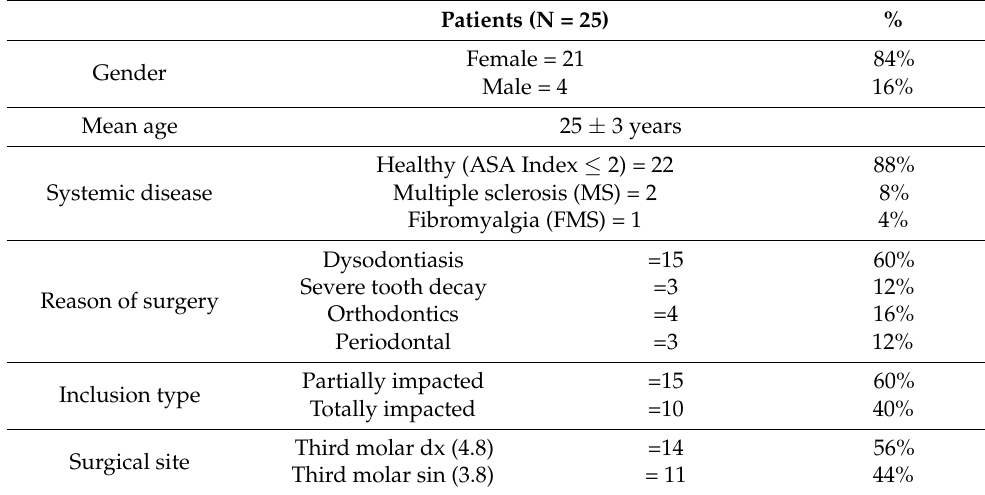
Table 2. Characteristics of selected patients at baseline.